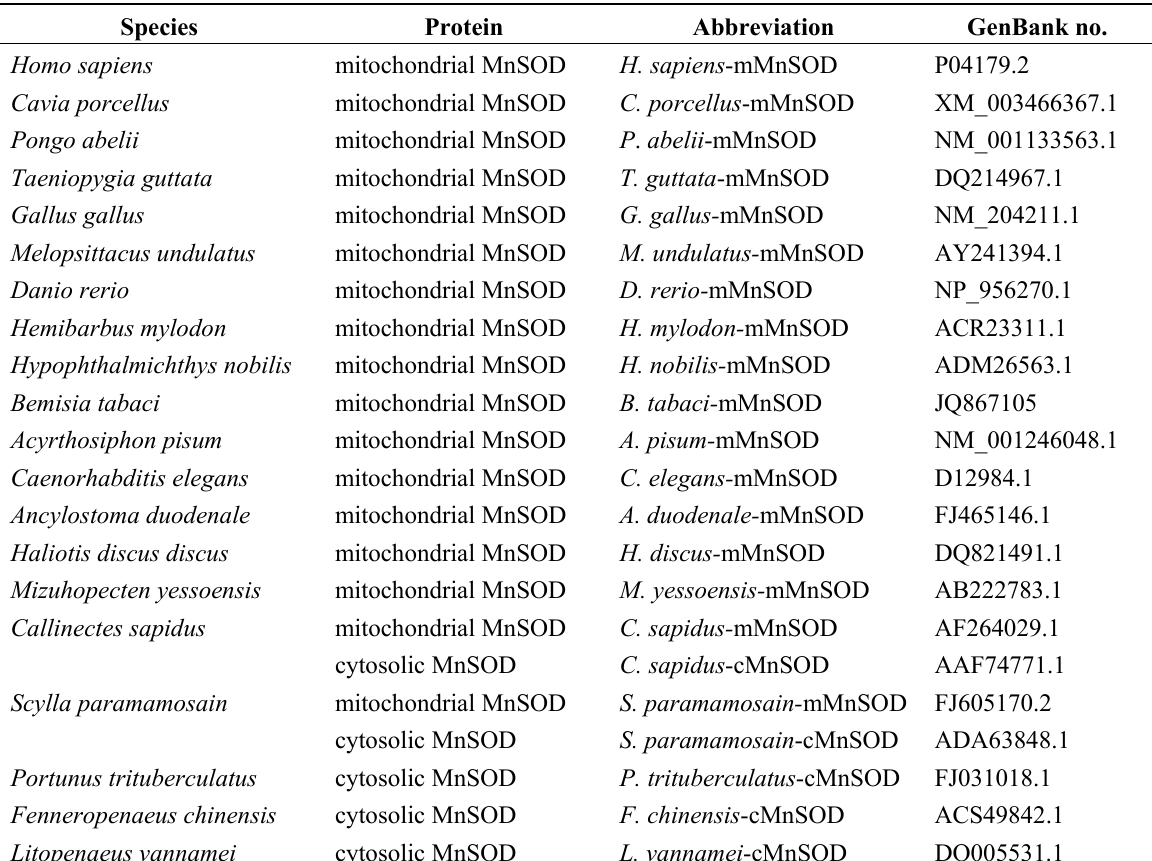
Table 1. Sequences of MnSOD used in this